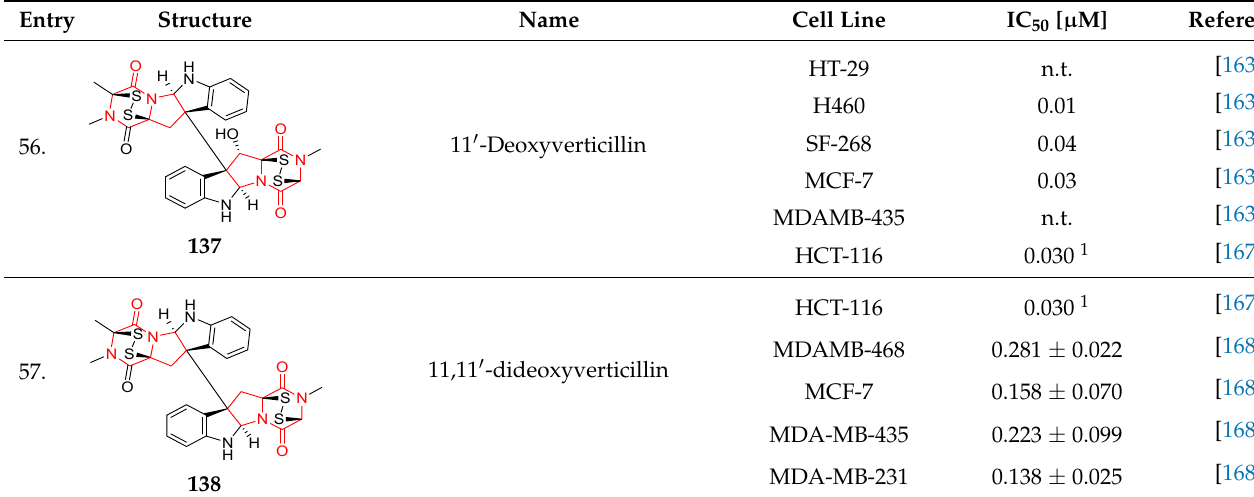
A series of five, tetracyclic, proline ‐ based DKPs, containing disulphide and trisulphide bridges, were isolated by Wang from deep sea ‐ derived fungus Acrostalagmus luteoalbus SCSIO F457 [154]. Luteoalbusin A ( 100 ), Luteoalbusin B ( 101 ), T988A ( 102 ), Gliocladine C ( 103 ) and Gliocladine D ( 104 ) were tested for cytotoxicity on four cancer cell lines: SF ‐ 268, MCF ‐ 7, NCI ‐ H460, and HepG ‐ 2, exhibiting significant effect, where MCF ‐ 7 cell line proved to be the most sensitive and NCI ‐ H460 line the most resistant to the compounds tested (Table 6, entries 18– 22). The highest cytotoxicity was observed for Luteoalbusin A ( 100 ) with IC 50 [ μ M] values of